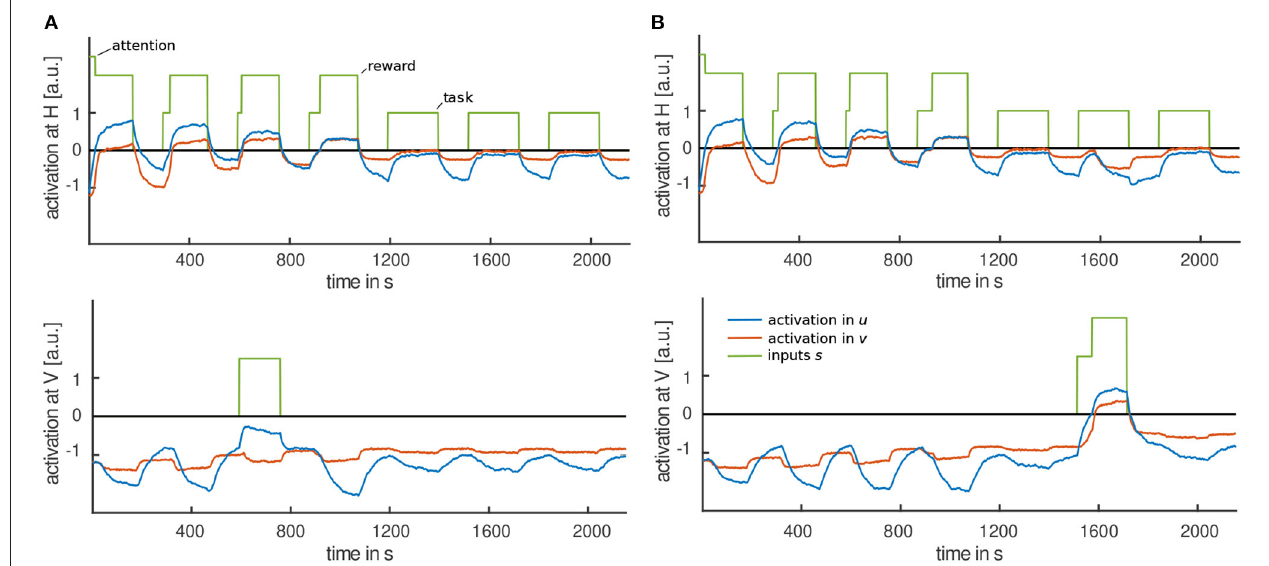
V on trial three. The =